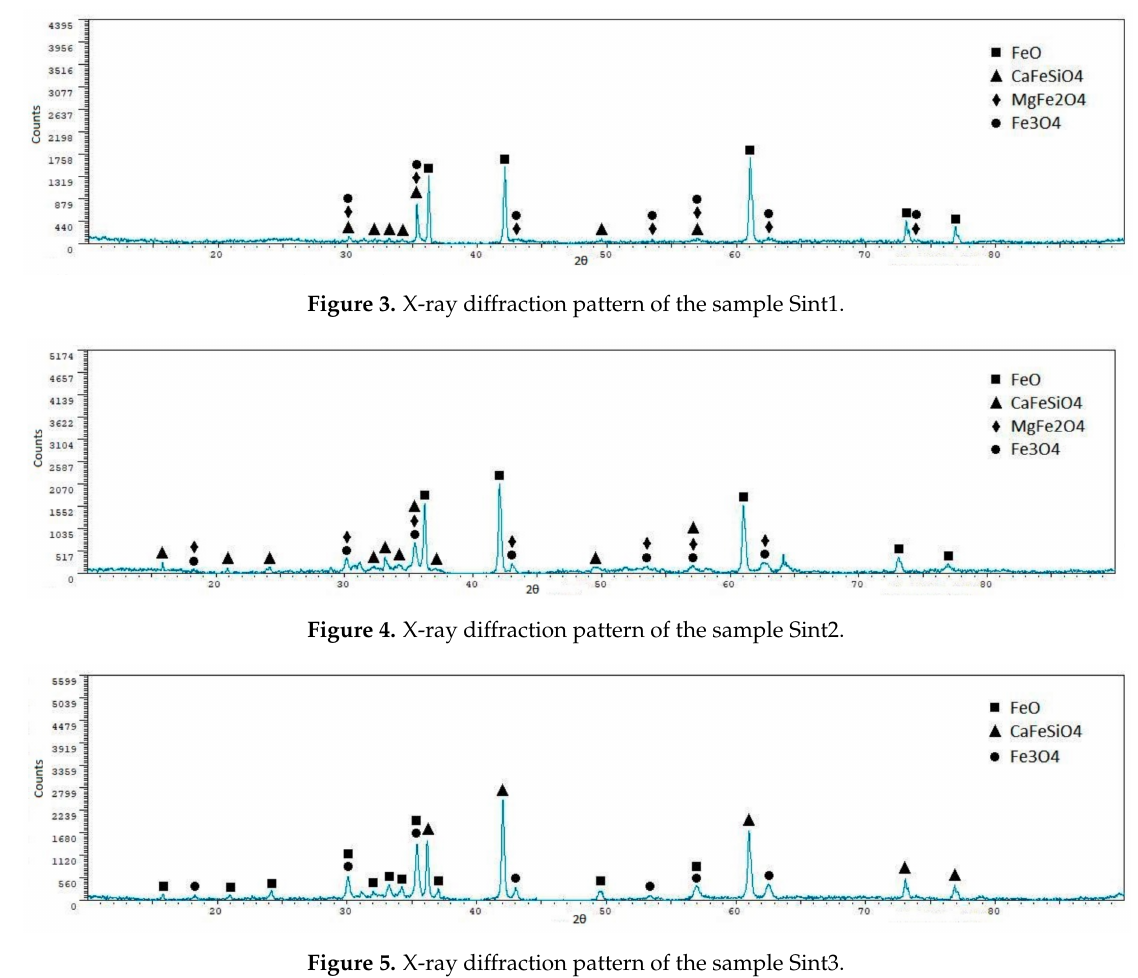
Figure 5. X-ray diffraction pattern of the sample